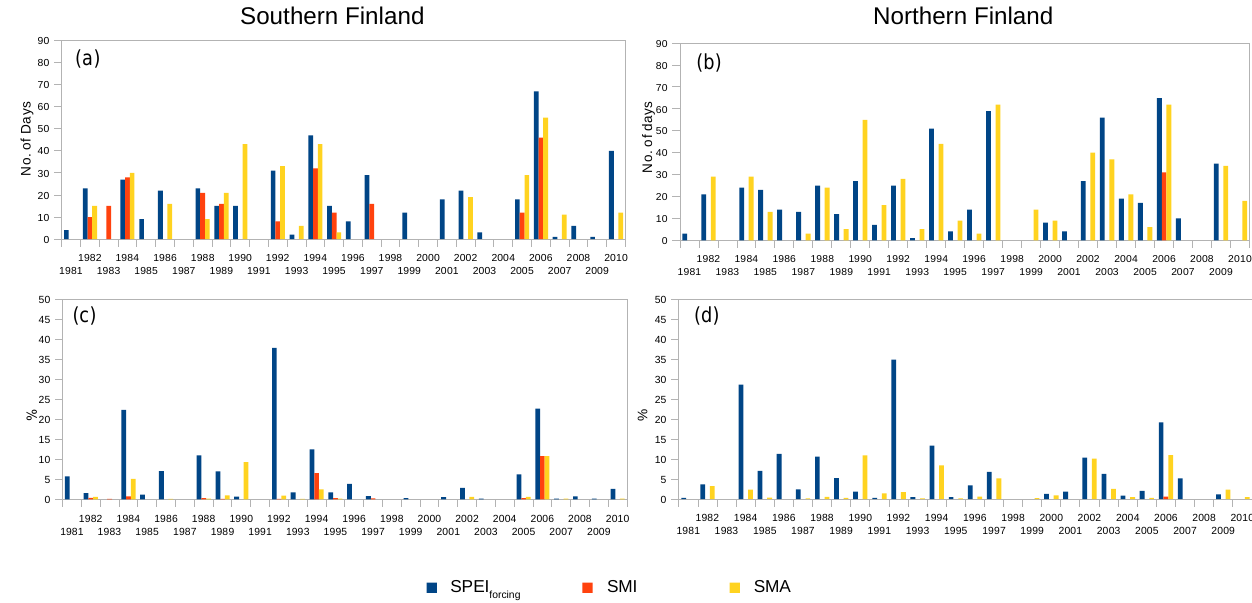
Figure 8. The summer drought periods (a, b) and the mean fractional areas affected by drought in these periods (c, d) induced by EDF events that are indicated by SMI, SMA, and SPEI forcing for southern Finland (left column panels) and northern Finland (right column panels) in the study period (note that areas with shallow soil (soil depth < 3m) are